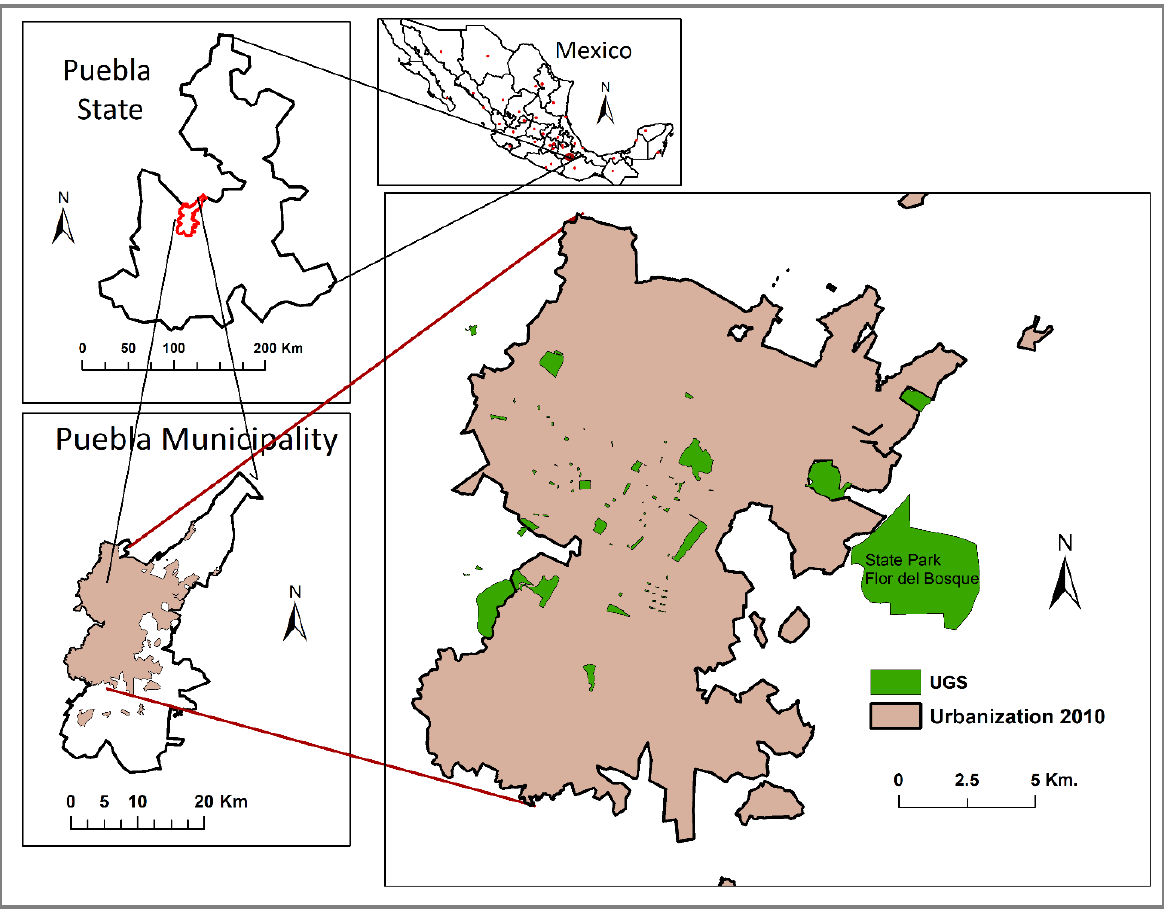
Figure 1. Location of Puebla, its 2010 urban extent, and 80 urban green spaces (UGSs). These UGSs are mostly public parks but also include five cemeteries, one golf course, three neighborhood green spaces, and a state park (Flor del Bosque with the size of 13,404,500 m 2 ). A map with numbered parks and corresponding photographs can be found here: https://arcg.is/1nqnnL.